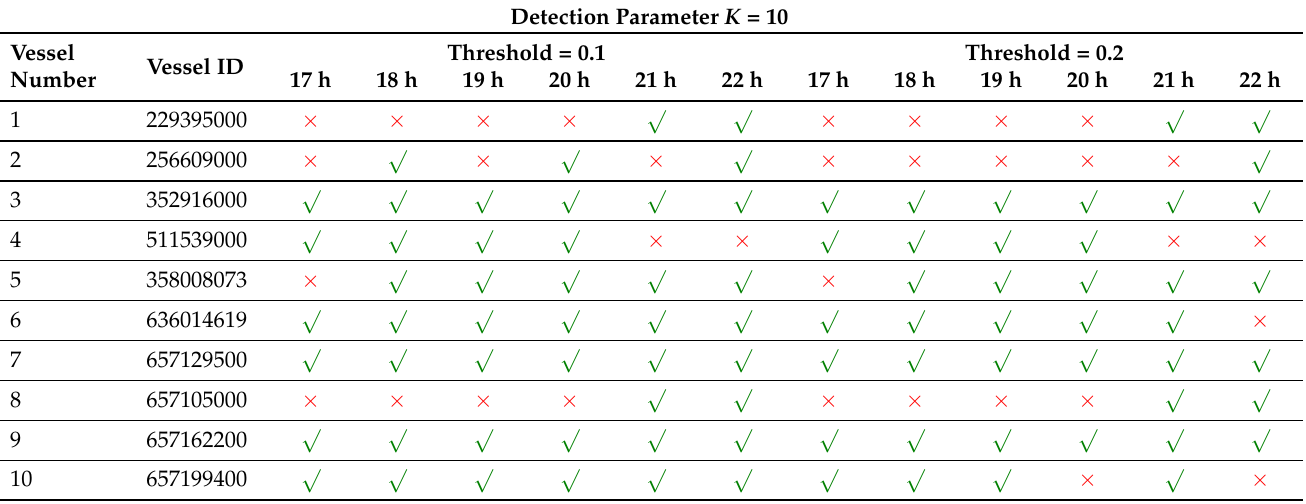
Table 2. Detection results for K = 10 and different threshold values in the selected period of